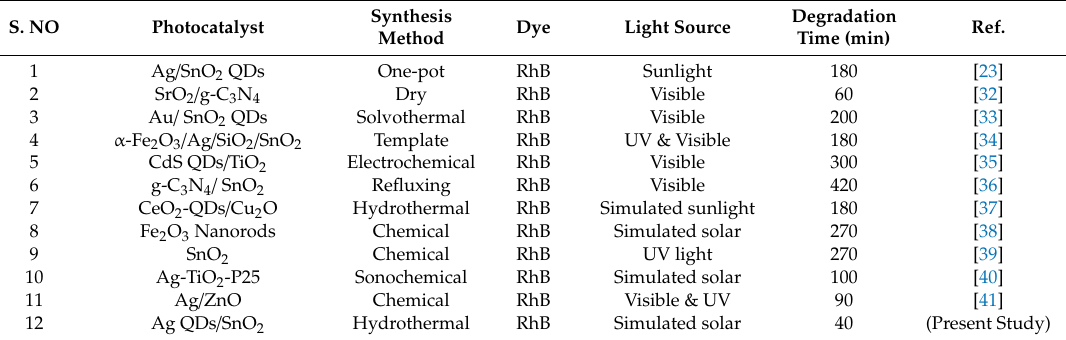
Table 1. Comparison of the Ag QDs / SnO 2 nanoflakes photocatalytic activity with recent literature examples.